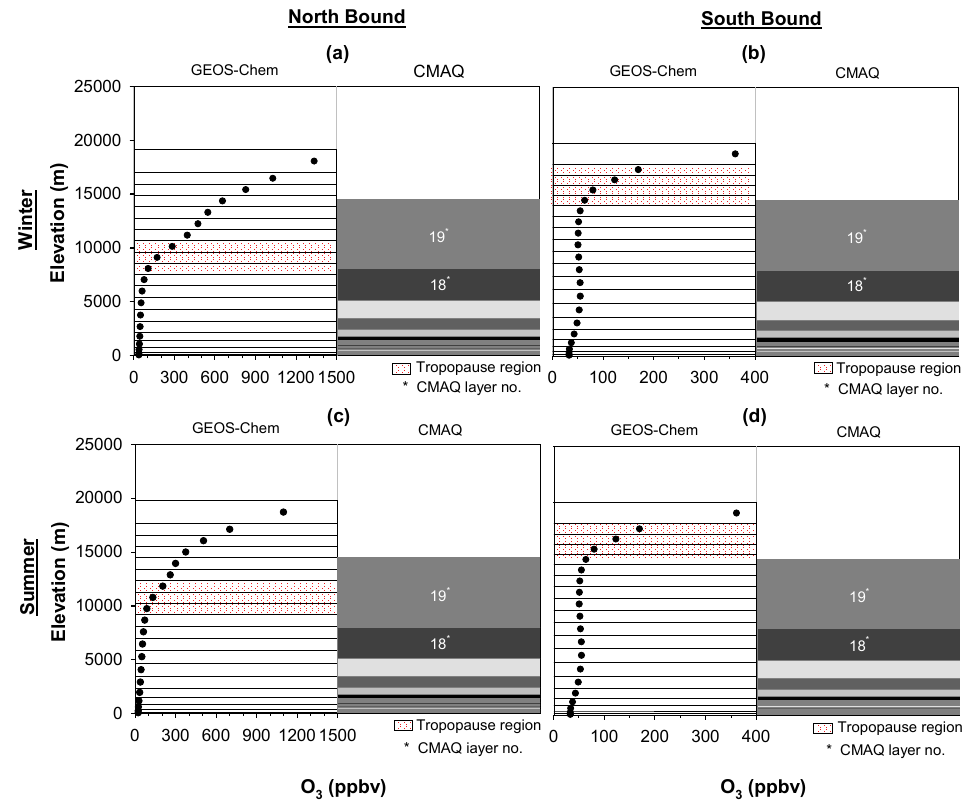
Fig. 5. Vertical ozone profiles from GEOS-Chem plotted with GEOS-Chem and CMAQ layers for both summer and winter, (a) north bound in winter, (b) south bound in winter, (c) north bound in summer, and (d) south bound in summer